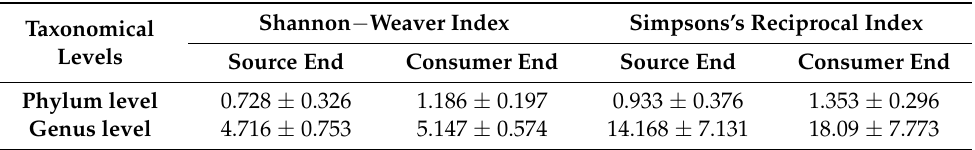
Table 1. Diversity indices of source and consumer-end biofilm samples at phylum and genus levels. The indices are calculated as mean ± standard